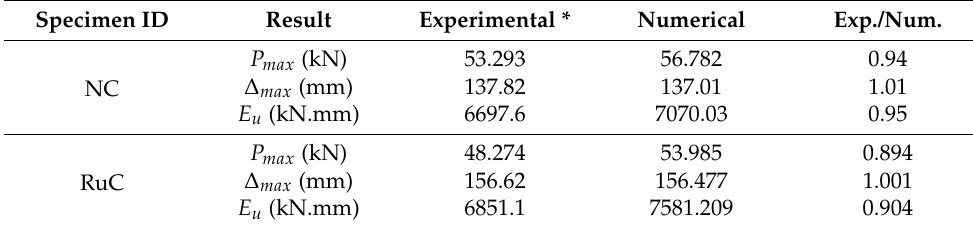
Table 8. Comparison of experimental and numerical load–displacement properties for the tested frames.